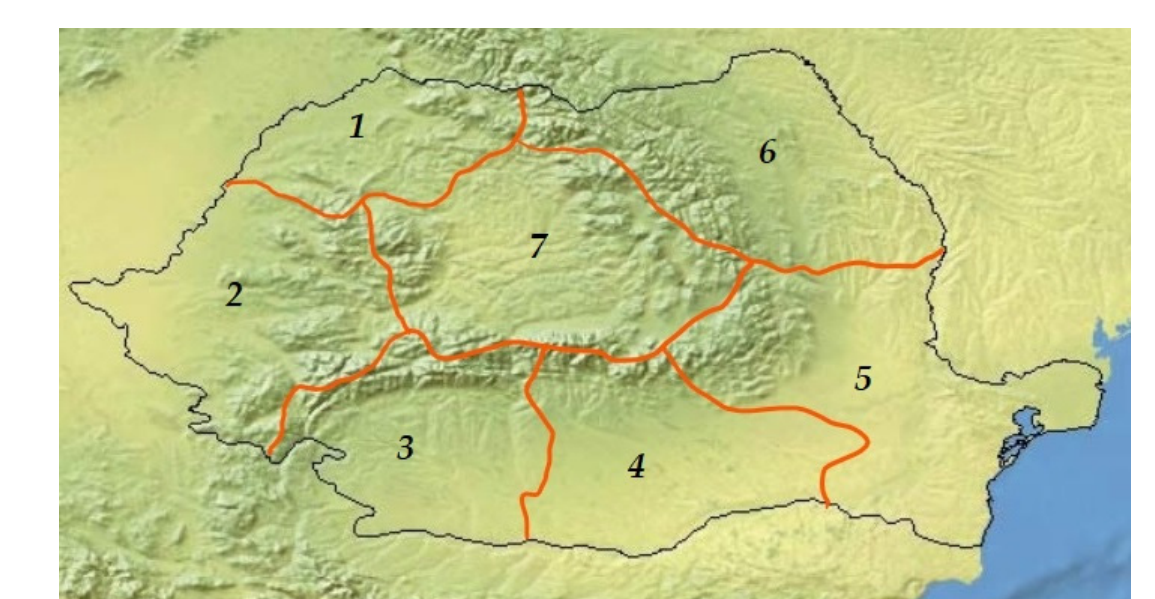
Figure A1. The seven development regions of Romania [30].